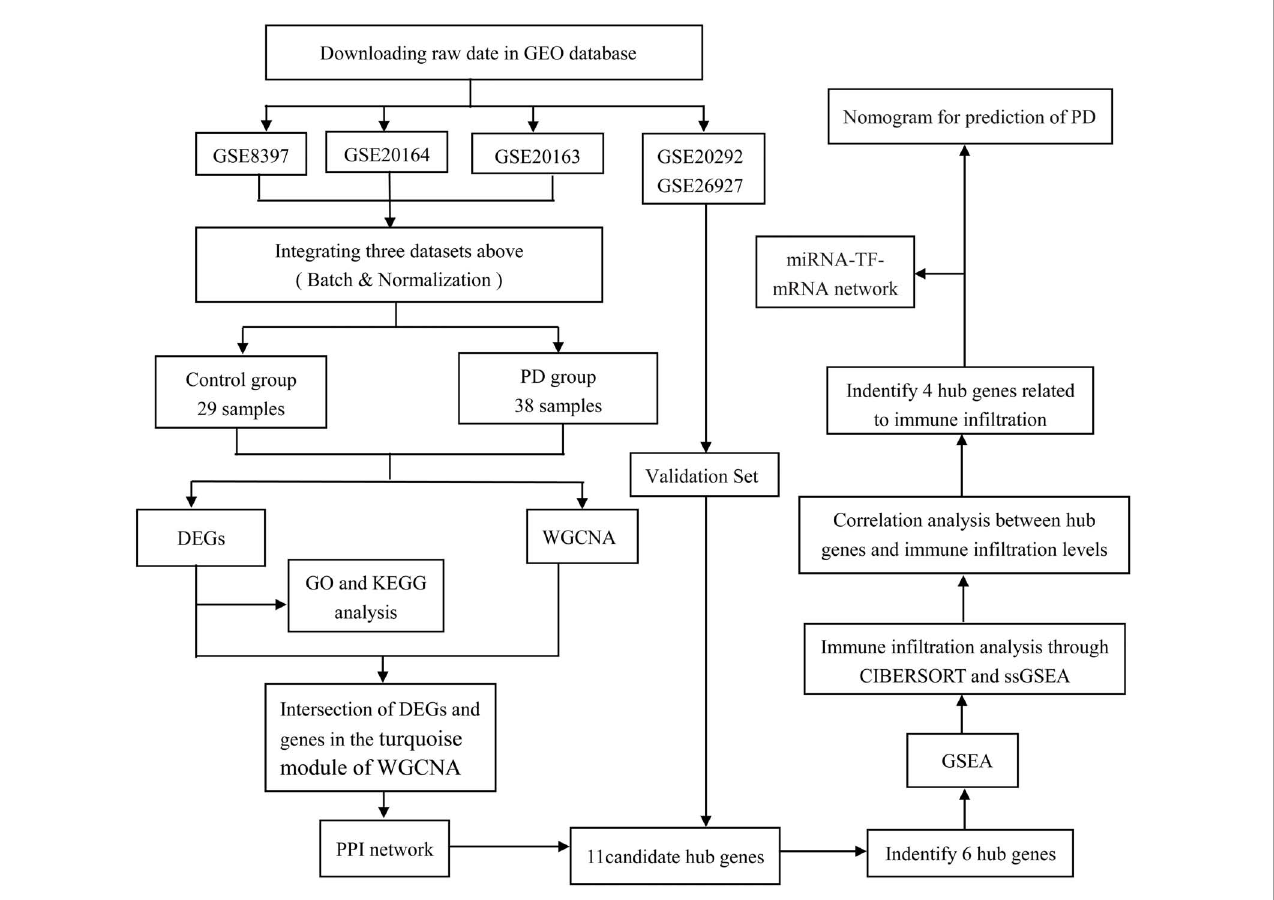
FIGURE1 Flowchart of the study. GEO, gene expression omnibus; DEGs, differentially expressed genes; WGCNA, weighted gene co-expression network analysis; ssGSEA, single-sample gene set enrichment analysis; GSEA, gene set enrichment analysis; GO, gene ontology; KEGG, Kyoto Encyclopedia of Genes and Genomes; PPI, protein–protein interaction; PD, Parkinson’s disease; TF, transcriptional